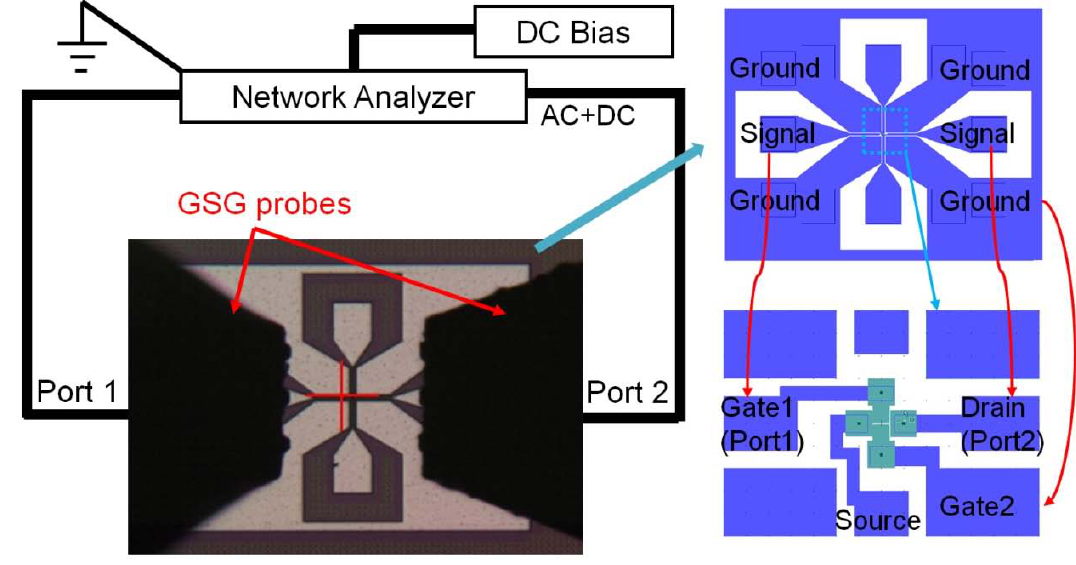
Figure 13. ( a ) The circuit model for the suspended beam with one side electrode using signal and ( b ) the magnitude of the S Architect for extracting S 21